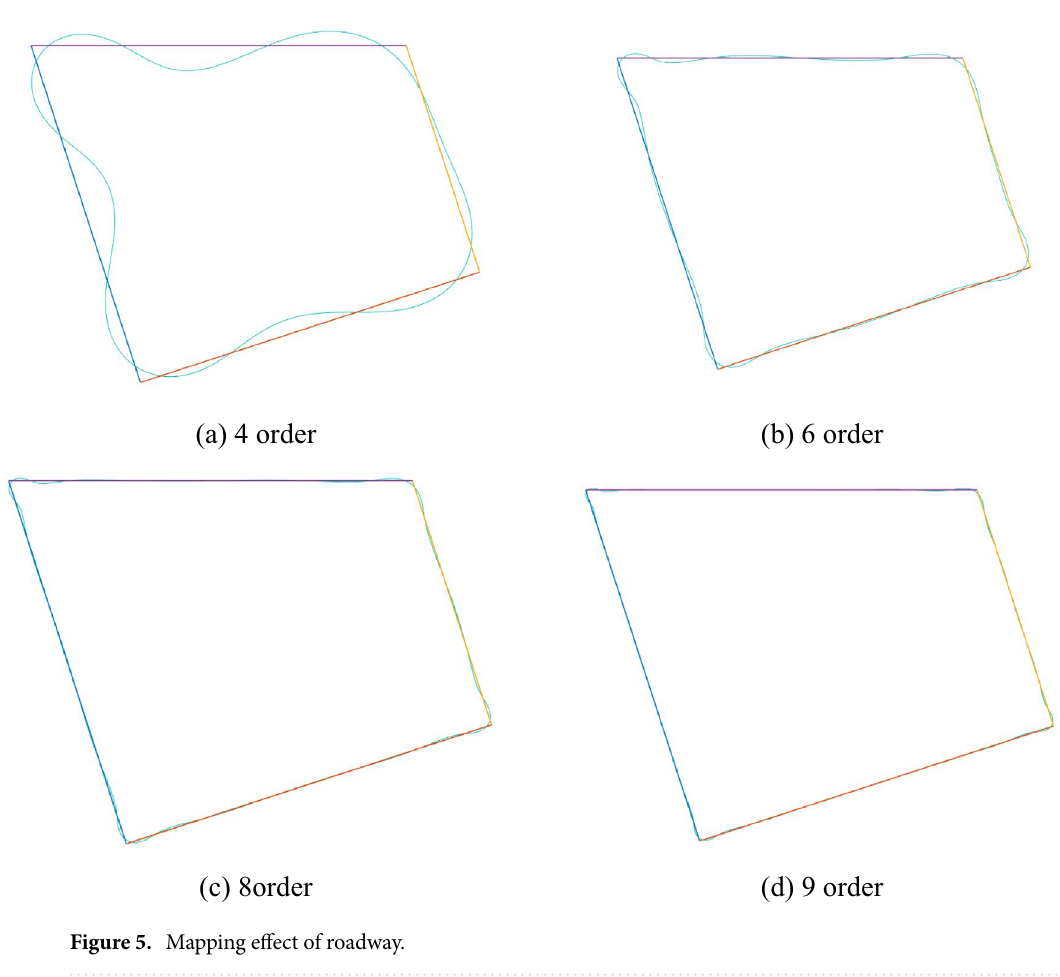
Figure 5. Mapping effect of